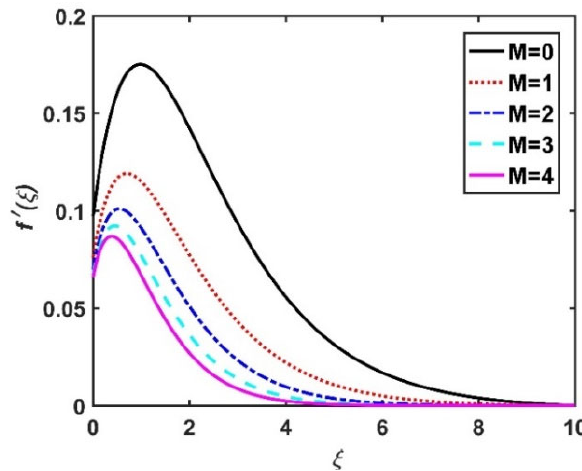
Figure 2. Impact of M on 𝑓′(cid:4666)𝜉(cid:4667) .